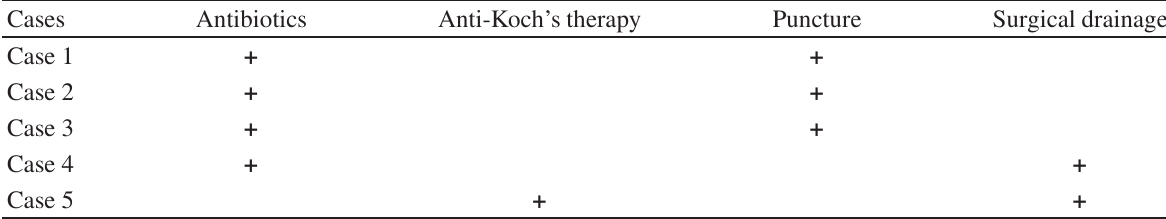
TABLE 2: Established